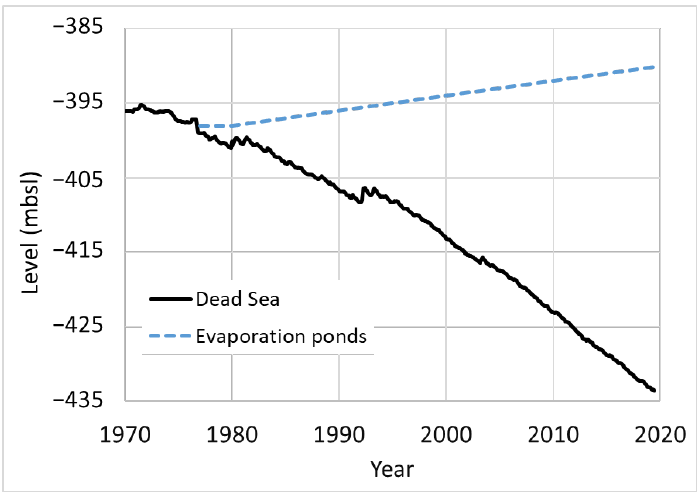
Figure 2. Temporal changes in level of the Dead Sea and evaporation ponds.